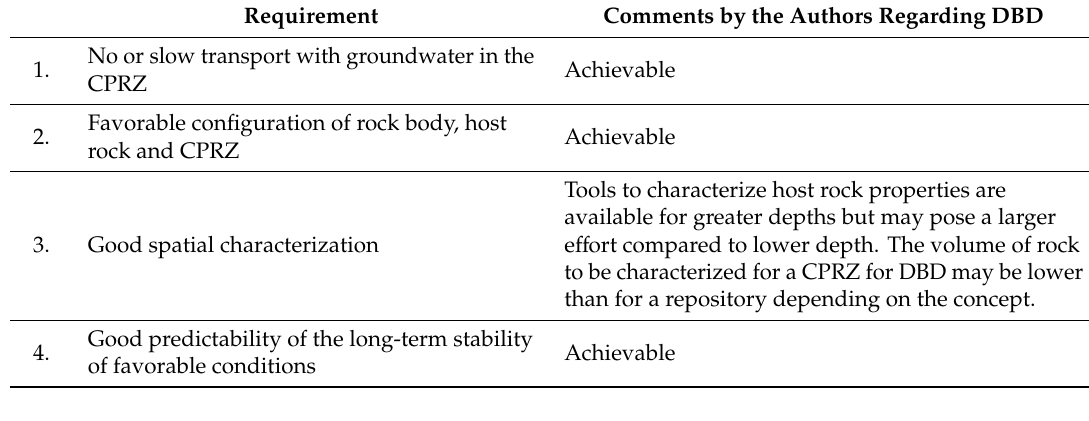
Table 1. Requirements of the weighting group 1: Quality of containment and reliability of its evidence.